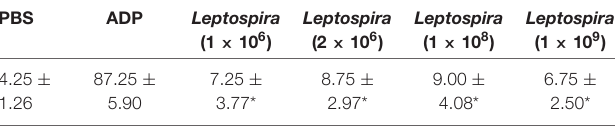
TABLE 1 | Platelet aggregation in response to different stimuli. PBS